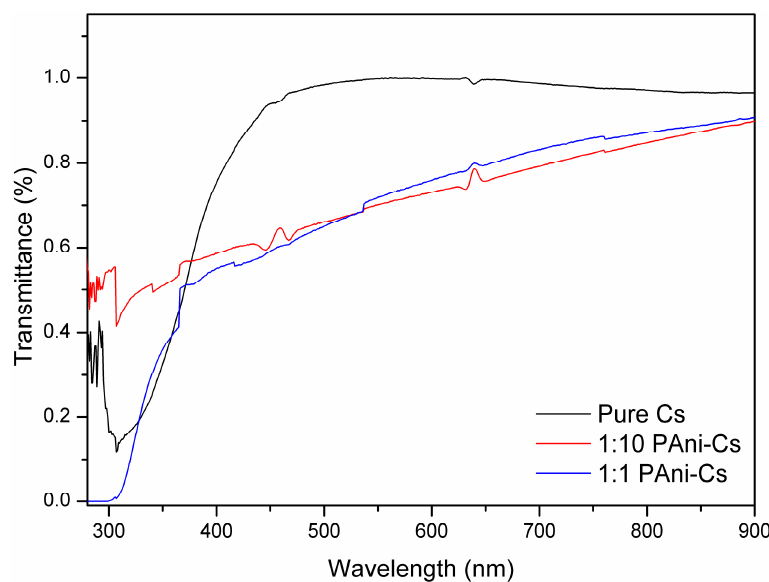
Figure 3. Ultraviolet–visible (UV–Vis) spectra of ( a ) pure chitosan (Cs), ( b ) 1:10 polyaniline–chitosan (PAni–Cs), and ( c ) 1:1 PAni–Cs.